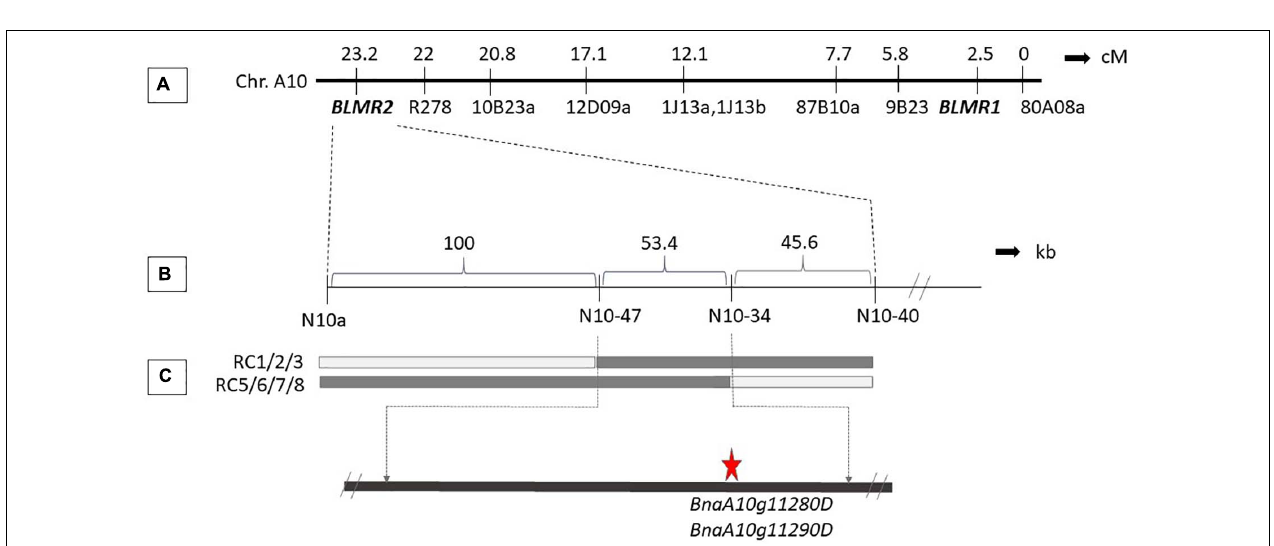
FIGURE 1 | Cotyledons of Surpass 400, near isogenic line W + BLMR2 and Westar, 14 days after inoculation (dai) of the pycnidiospore suspension (2 × 10 7 spores/mL) of Leptosphaeria maculans isolate 87-41. Surpass 400 showing high resistance (A) ; W + BLMR2 showing intermedium resistance (B) ; and Westar with the susceptible phenotype (C) .